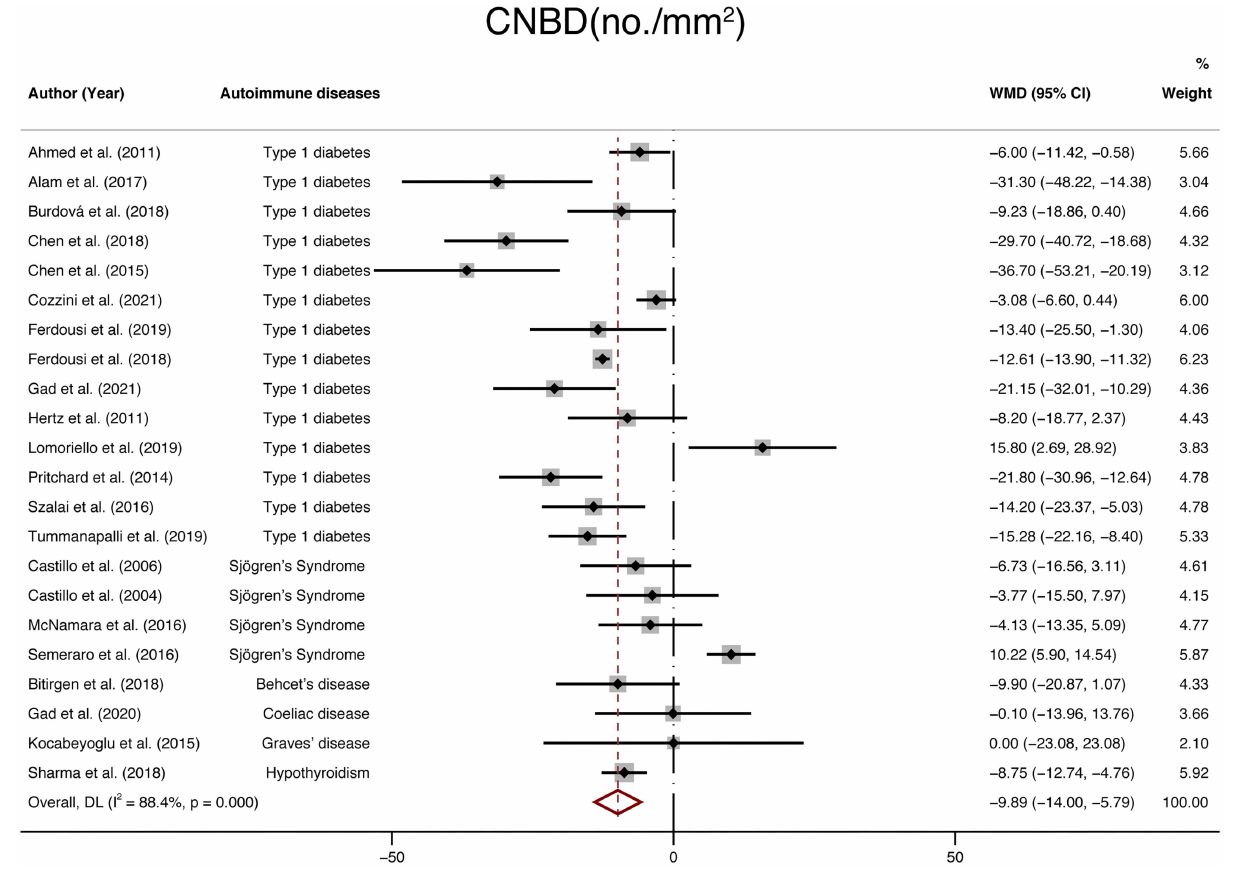
FIGURE 6 | Forest plot of the WMD of CNBD between the NNAI group and the control group. WMD, weighted mean difference; CI, confidence interval; CNBD, corneal nerve branch density; NNAI, non-neurological autoimmune (diseases).